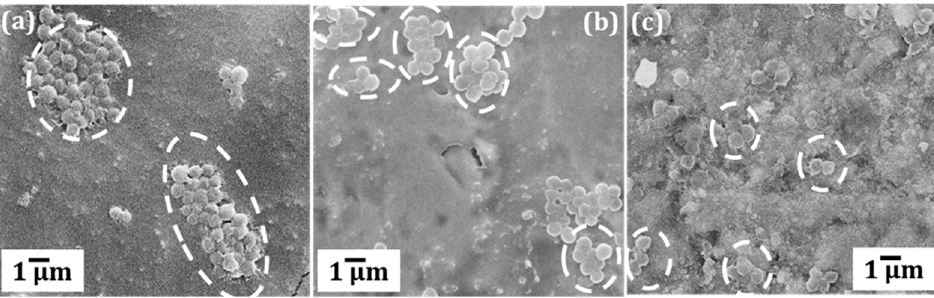
Figure 3. Colony forming units ( CFU) of bacterial growth on pristine, cold rolled and cry-rolled surface.